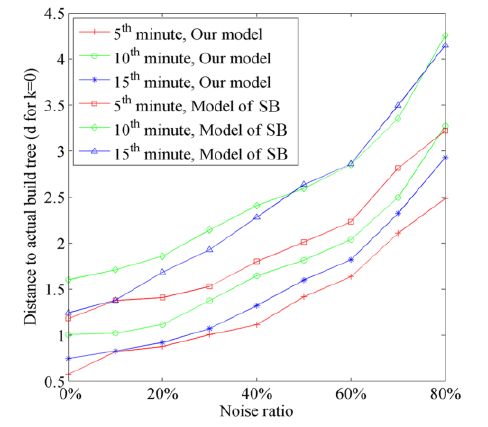
Figure 2. Distance to the actual build tree ( for ), PvP Match-ups (SB is Synnaeve-Bessiere [21]).